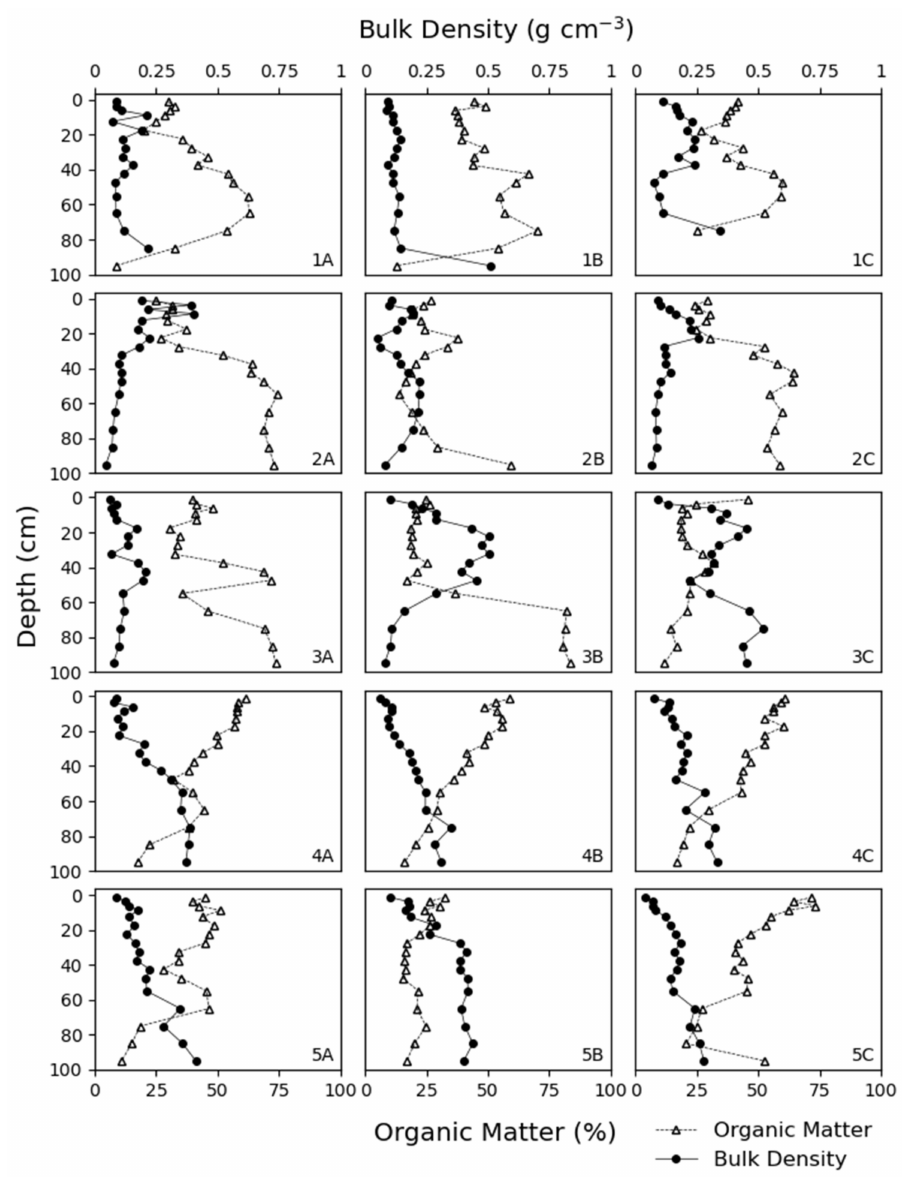
Figure 2. Bulk density (g cm − 3 ) and organic matter (%) values vs. depth across 100 cm cores for sites 1 − 5 (subsites A, B, C) along the Nanticoke